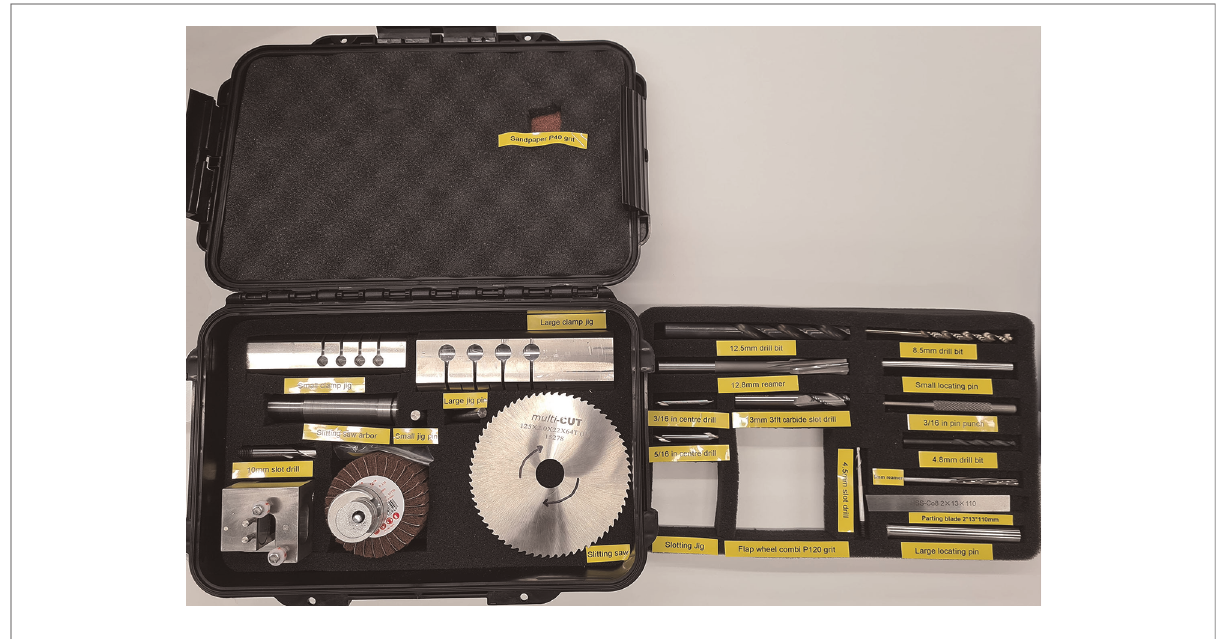
FIGURE 2 Imperial fi xator manufacturing toolkit.